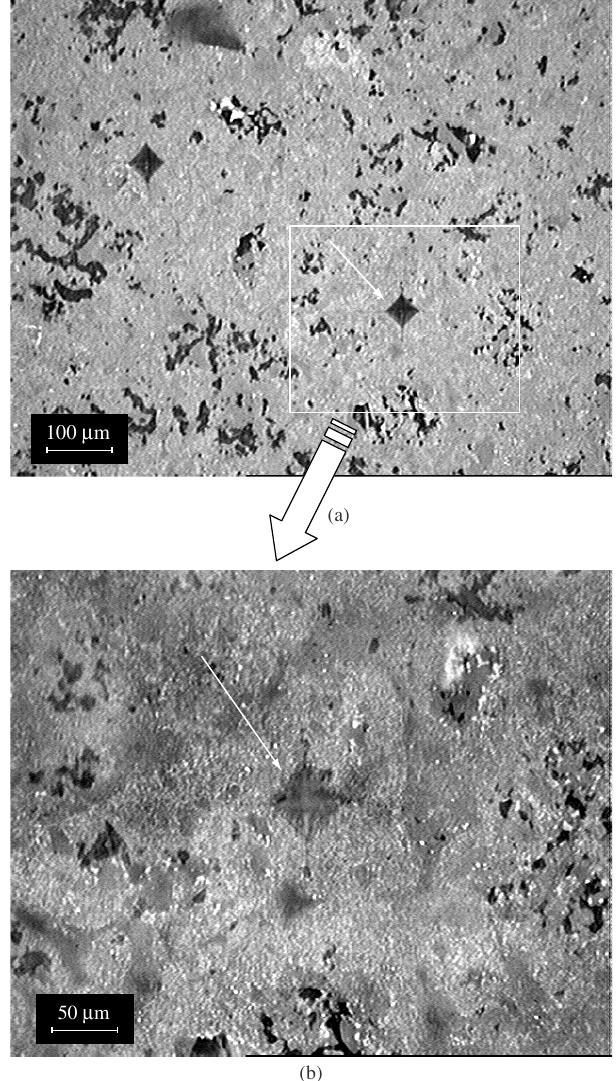
Figure 8. Optical micrographs of the polished surface of the sample pyrolysedOpticalmicrographsofthepolishedsurfaceofthesamplepyrolysedOpticalmicrographsofthepolishedsurfaceofthesamplepyrolysed at 1600 °C/1 h: a) showing Vickers indentations; b) indentation in a region with a mixture of